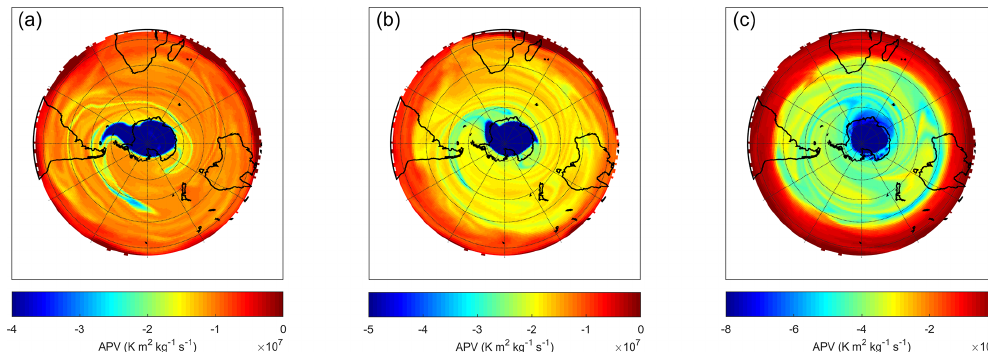
Figure 7. APV maps from MIMOSA-CHIM at 435K (a) , 485K (b) and 600K (c) on 2 September 2014.